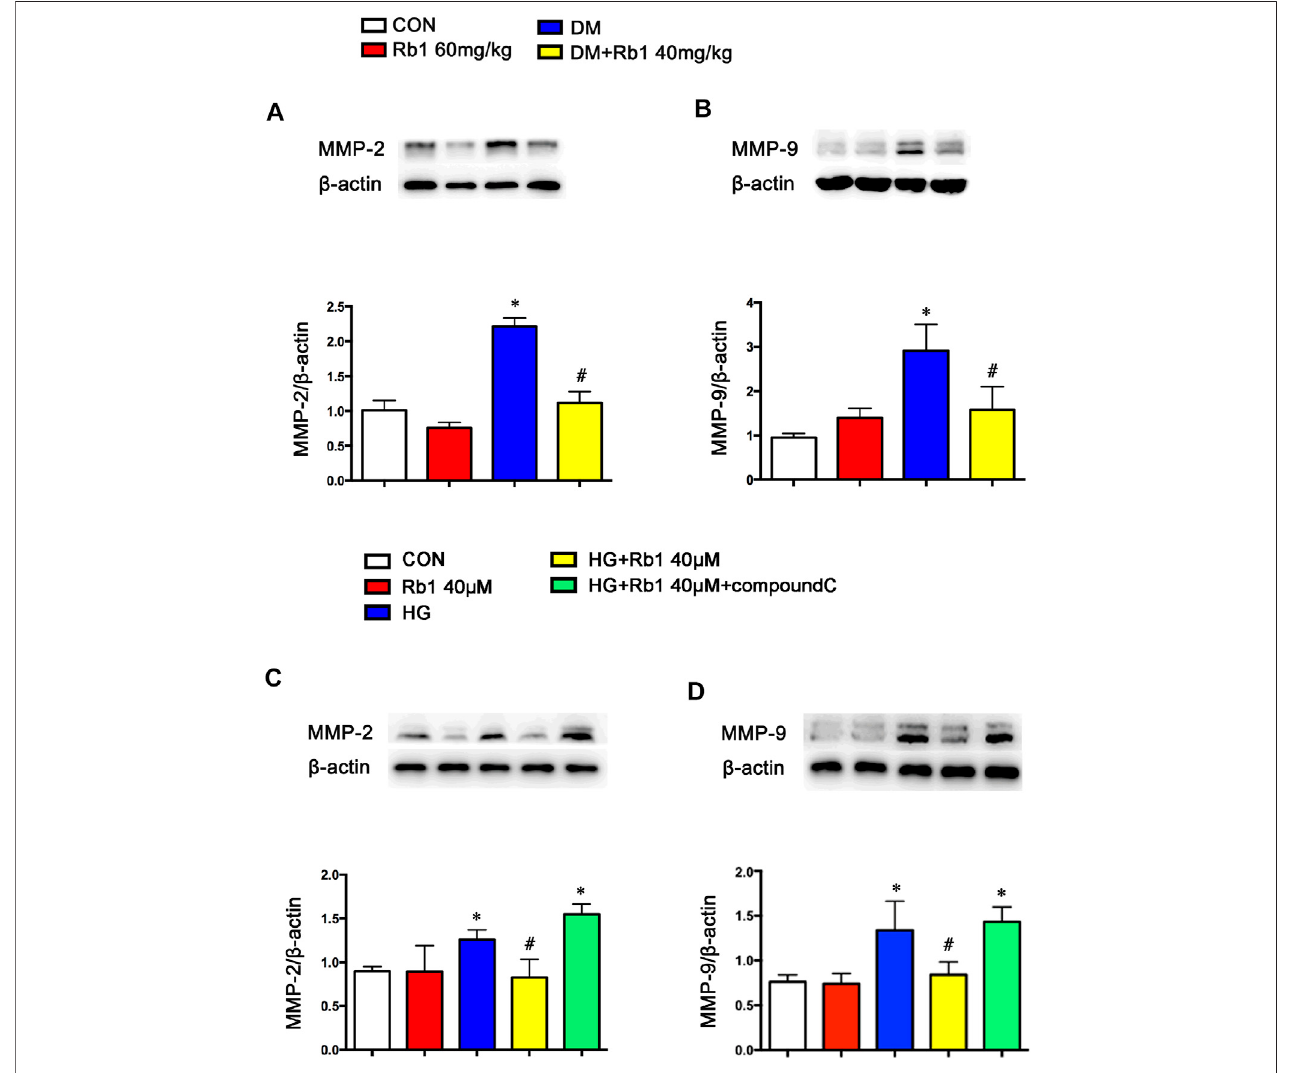
FIGURE 5 | Rb1 suppresses MMP-2 and MMP-9 expression. Representative Western blot bands and semiquantitative analysis of (A) MMP-2 and (B) MMP-9 protein expression in aorta. Representative Western blot bands and semiquantitative analysis of (C) MMP-2 and (D) MMP-9 protein expression in VSMCs. Data are mean ± SEM. n (cid:2) 5 – 6, * p < 0.05 vs. Control; # p < 0.05 DM + Rb1 vs. DM and HG + Rb1 vs.